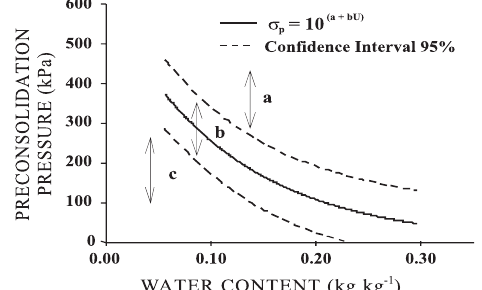
Figure 1. Criteria used to analyze the effect of the wood load and harvest operations on the preconsolidation pressure of the Ultisol. (a) Region with additional soil compaction; (b) region with no soil compaction (this region indicates the soil samples which could suffer soil compaction in the next harvest operations, if applied pressures are larger than the higher limit of the confidence interval); and (c) region with no soil compaction.